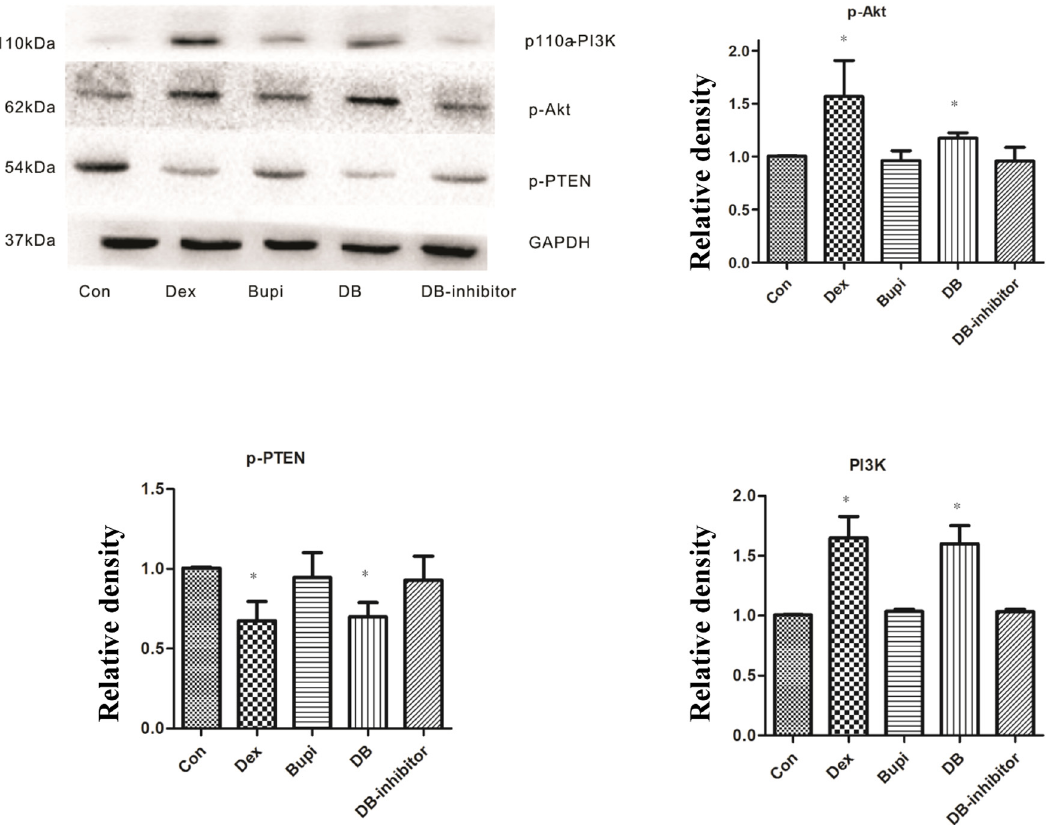
Figure 4: The protein expression of related factors in the PI3K/Akt pathway. PI3K and p - Akt protein levels in DB group and Dex group were higher than that in other three groups. The expression of p - PTEN in DB group and Dex group was lower than that in other three groups. There was no signi fi cant di ff erence in the expression of Akt and PTEN between the two groups. * P < 0.05 vs Con, Bupi, and DB